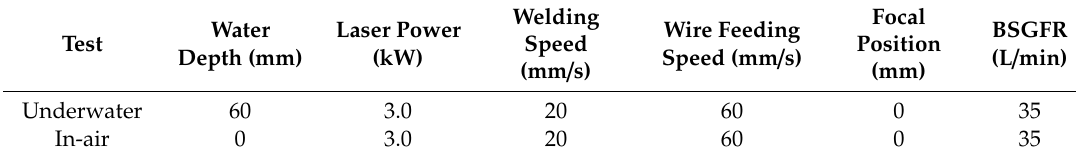
Table 4. Welding test parameters. Figure 13. The influence of laser powers on tensile strength and impact toughness.